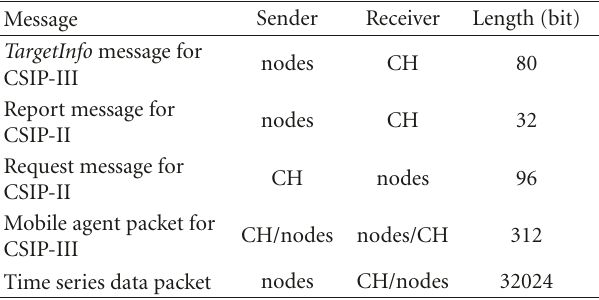
Table 2: The message descriptions and their sizes used in simula-